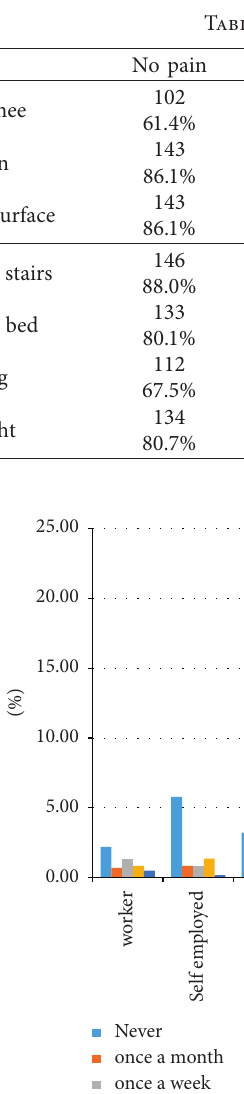
Figure 1: The prevalence of knee pain associated with type of